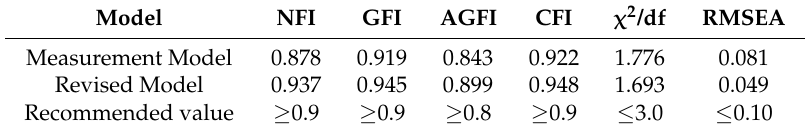
Table 3. Summary of the overall fit indices for the measurement model ( n = 328).